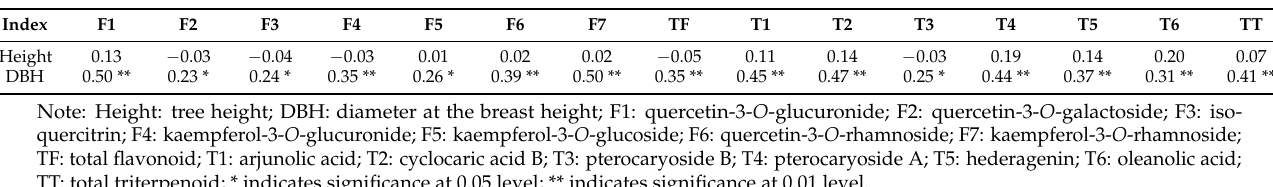
Table 4. Pearson’s correlation coefficients between the annual mean growth (tree height and DBH) and leaf phytochemical content values of 13 C. paliurus genotypes across two test